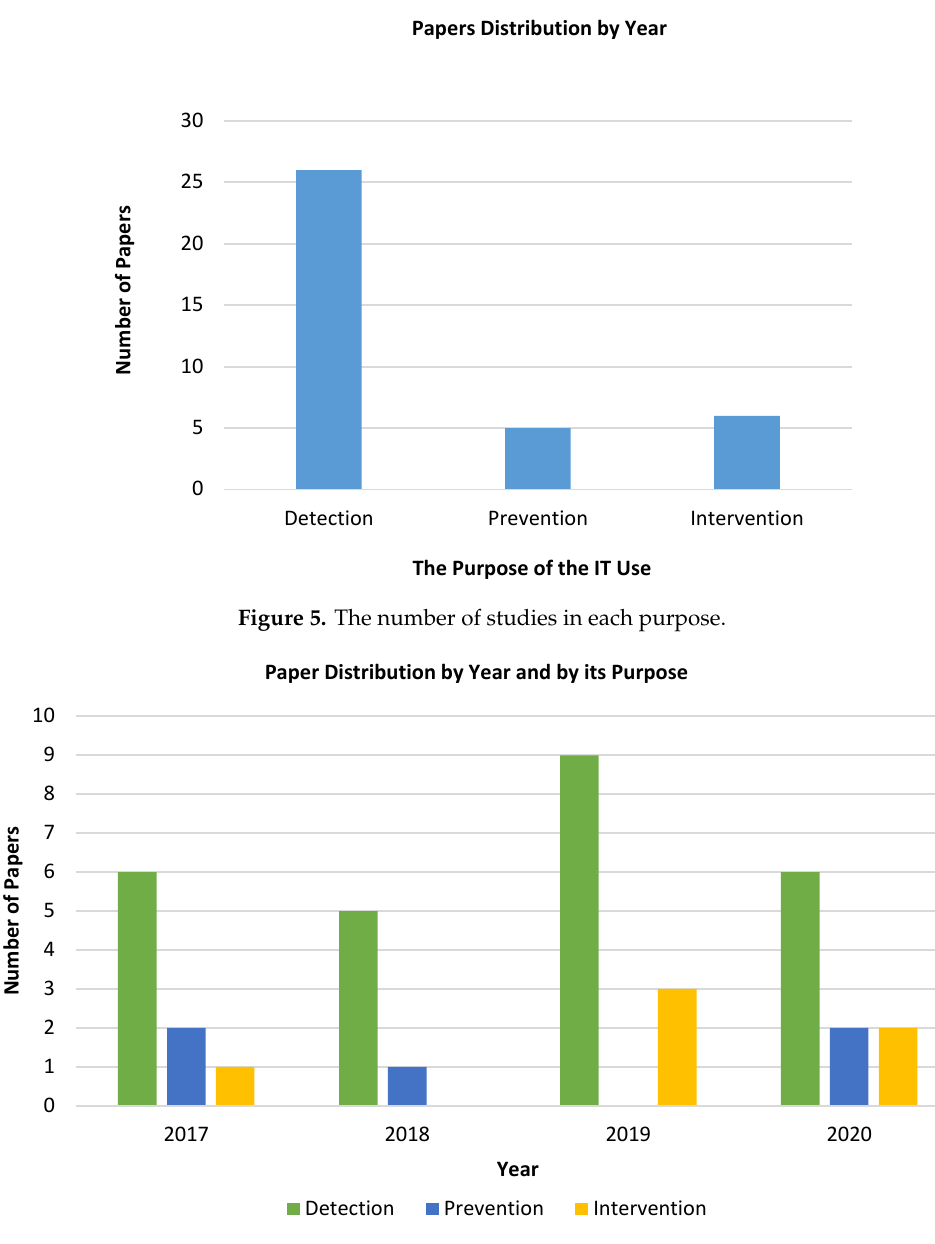
Figure 6. The distribution of studies by year and category.